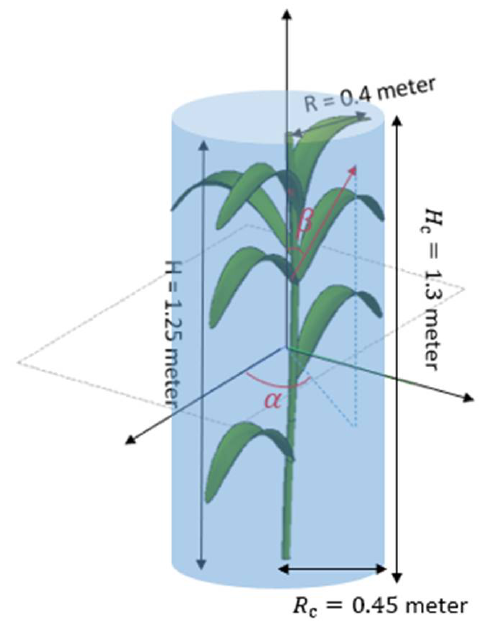
Figure 1. Single corn plant geometry.